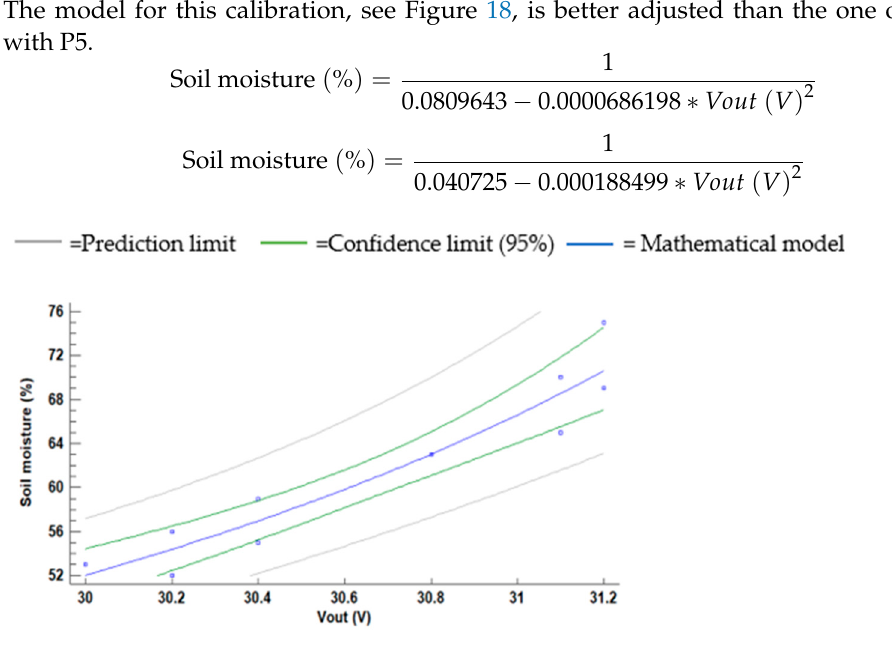
Figure 17. Vout of P5 using S1 and its mathematical model.